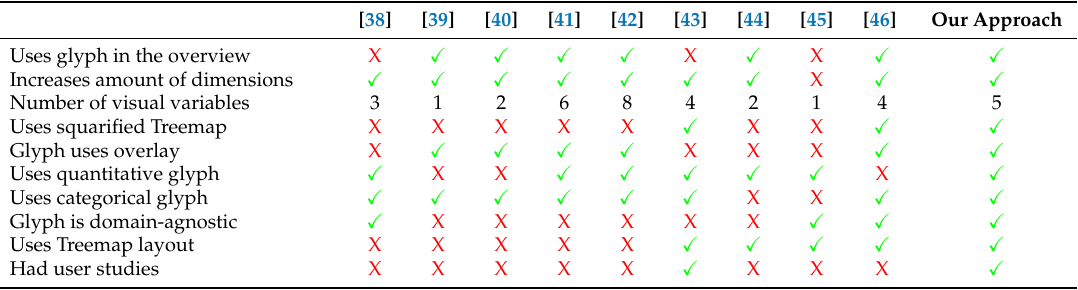
Table 1. Proposals that used glyphs and proposals that used glyphs in treemaps compared with our approach.